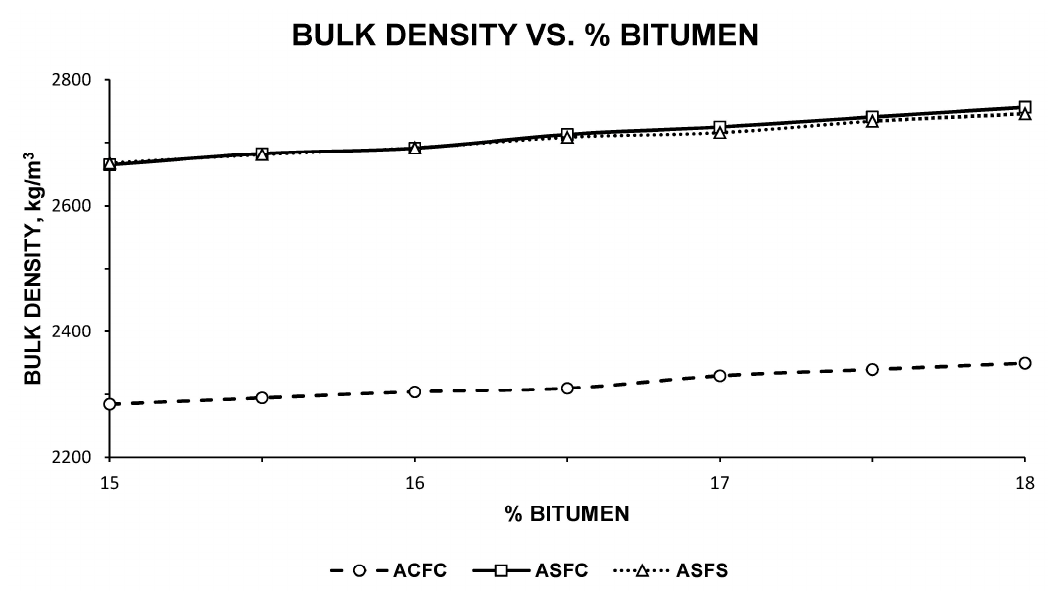
Figure 3. Bulk density of the families of bituminous mixtures ACFC, ASFC and ASFS with different percentages of bitumen in volume of aggregate.